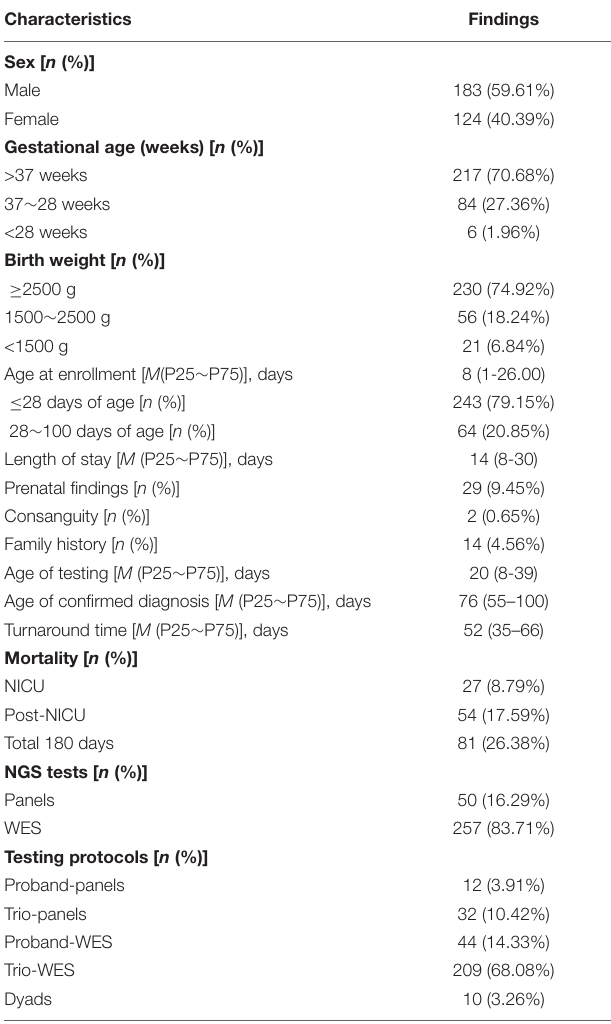
Supplementary Table S2 ). As for the spectrum of